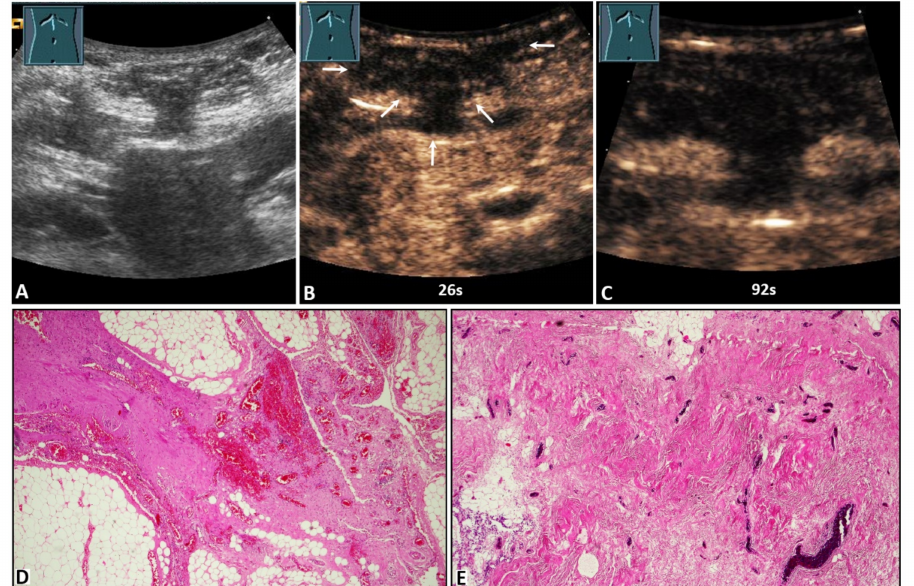
Figure 4. A 59-year-old male patient with acute peritoneal pain in the umbilical region and a palpable tumor. ( A ) B-mode ultrasound shows a complex lesion located in the abdominal wall, with visualization of omental hernia content. ( B , C ) On contrast-enhanced ultrasound, the lesion shows absent enhancement after 26 s (arrows) and 92 s. ( D ) Omentum with fibrotic strands, including dilated hyperemic capillaries (4 × magnification). ( E ) Fibrotic hernia sac with dilated hyperemic capillaries (10 ×